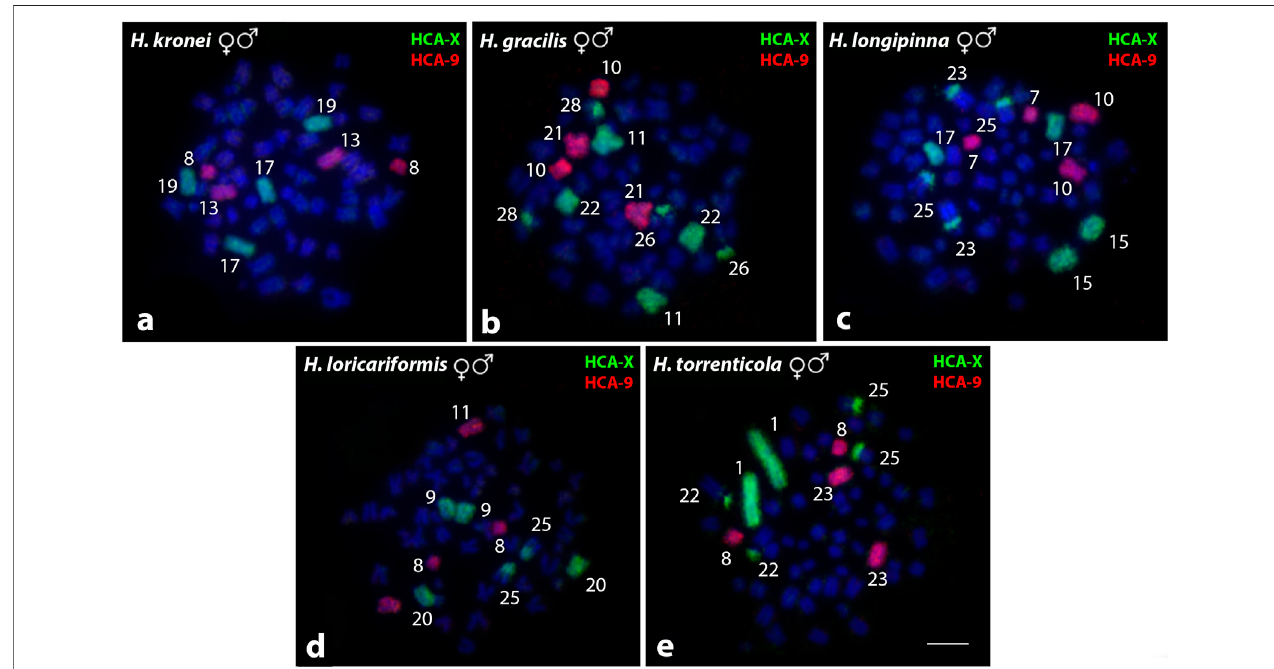
FIGURE 4 | Whole chromosome paint by FISH using HCA-X (green) and HCA-9 probes (red) in Harttia species without heteromorphic SCS. The numbers of the labeled chromosome pairs are highlighted in the images. Metaphases of H. kronei (A) , H. gracilis (B) , H. longipinna (C) , H. loricariformis (D) , and H. torrenticola (E) . Bar = 5